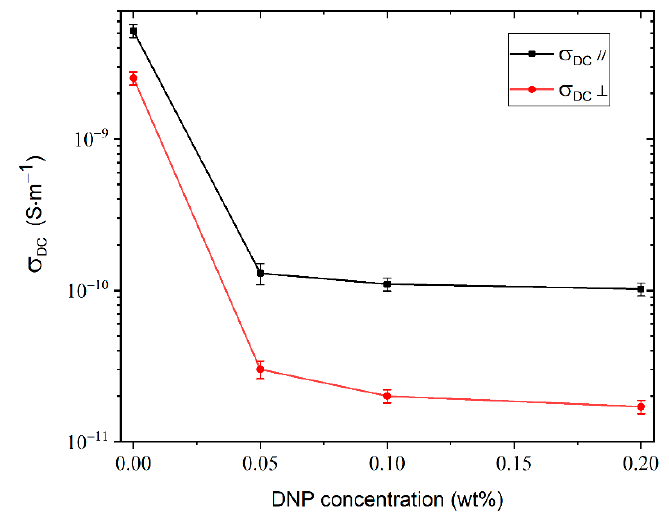
Figure 5. Variation of DC conductivity as a function of concentration of DNPs added to a purified LC mixture.